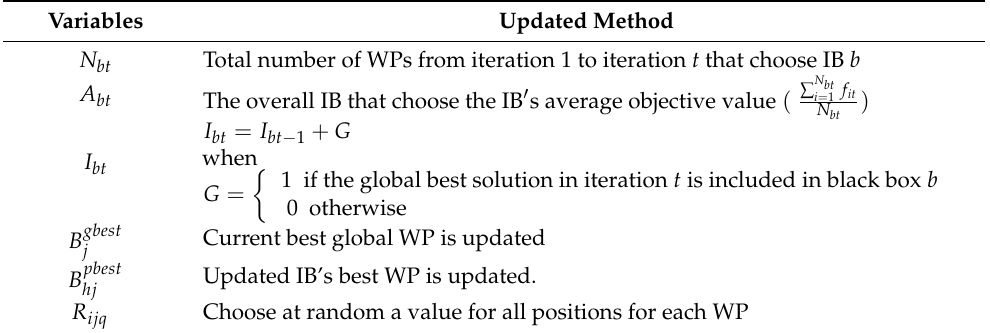
Table 4. Updated role of the heuristics information.